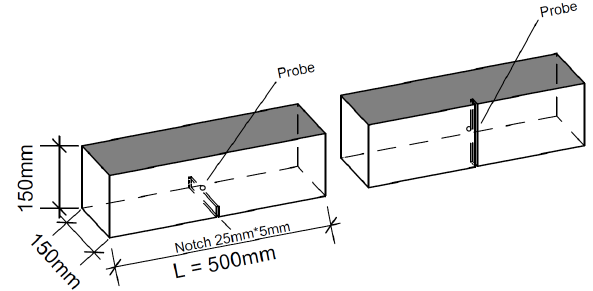
Figure 2. A sketch showing the location of the notch for the bending test in relation to the filling side and the location of the fiber orientation probes, probe 1 is located for use with the casting bottom as notched surface ( left picture ), and probe 2 is located for use with a side wall as notched surface ( right picture ). The darker surface of the sample beam indicates the filling side during the